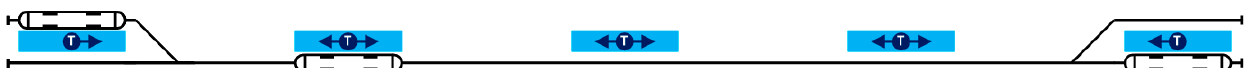
Figure 7. Using the bi-directional tram to serve tram stops located on one side of the track.